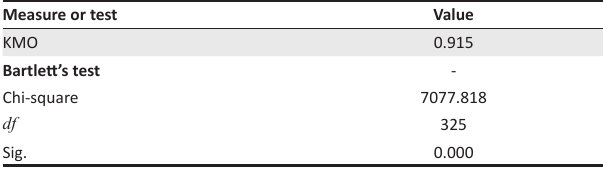
TABLE 4: Kaiser–Meyer–Olkin measure of sampling adequacy and Bartlett’s test of sphericity.